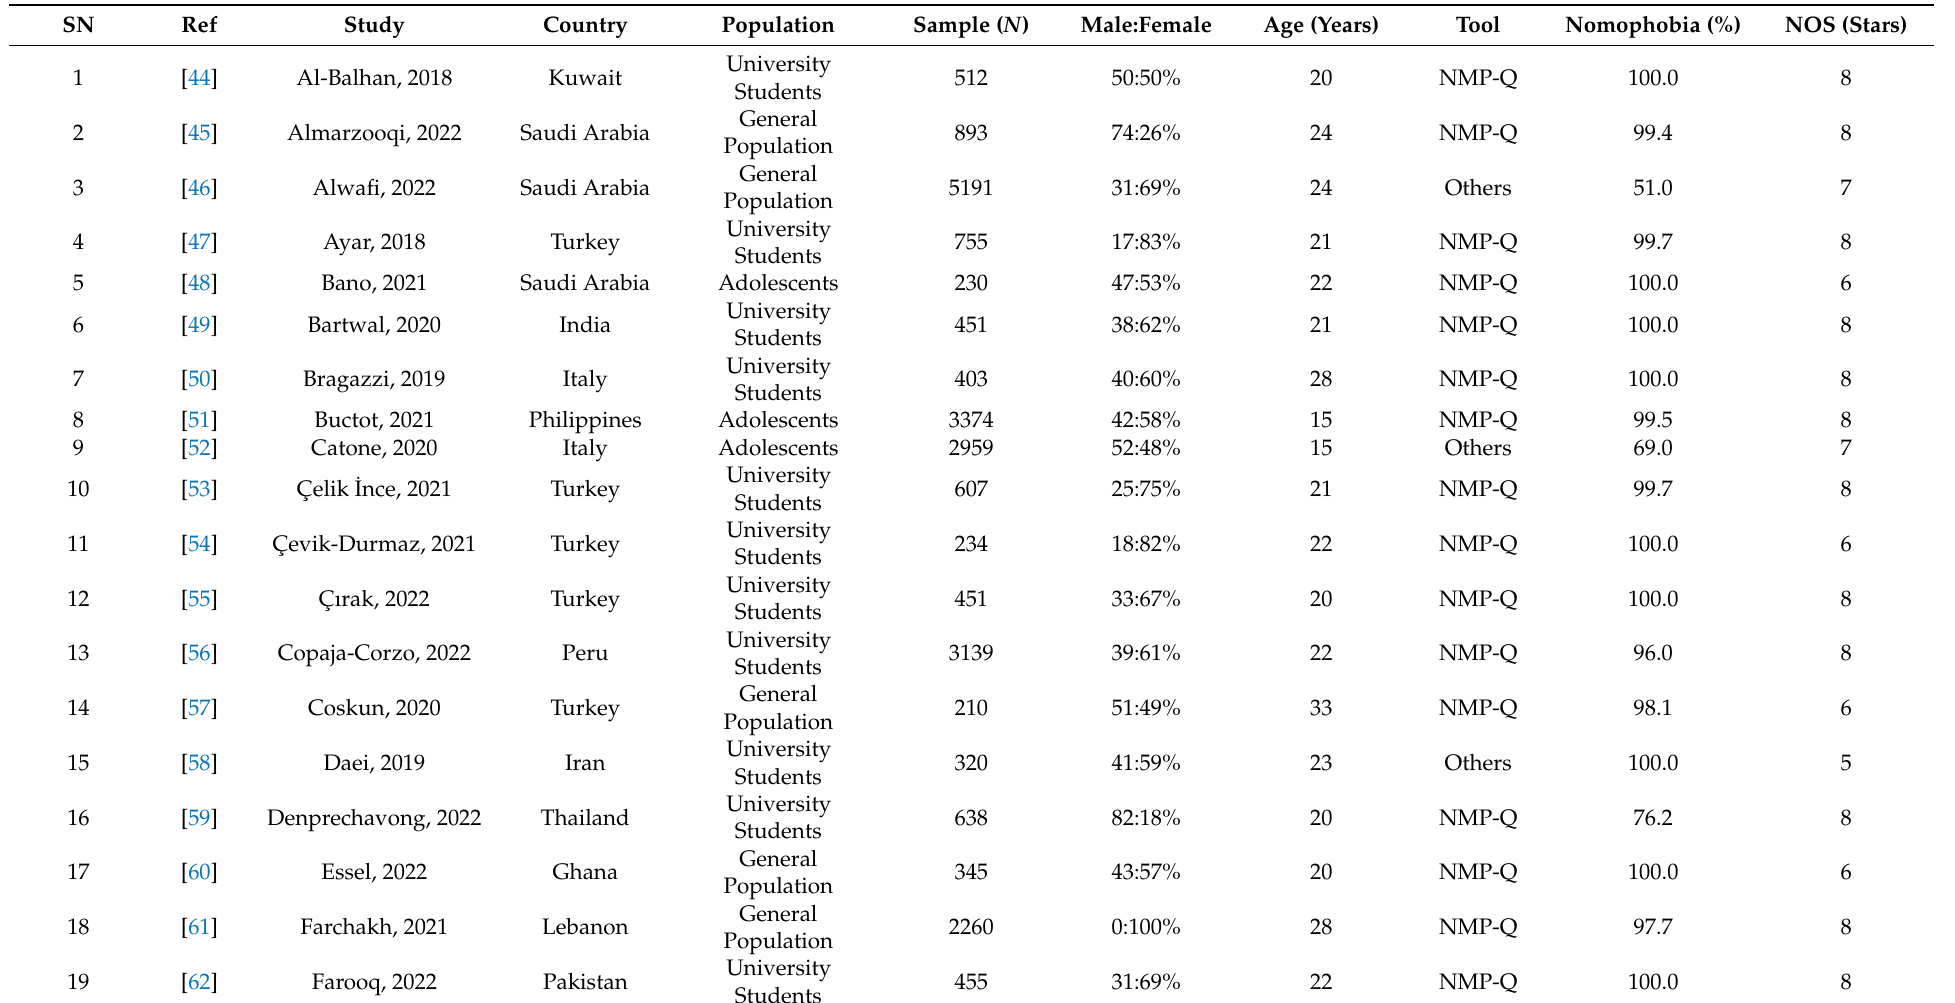
Table 1. Summary of studies included in the systematic review and meta-analysis about the prevalence of nomophobia